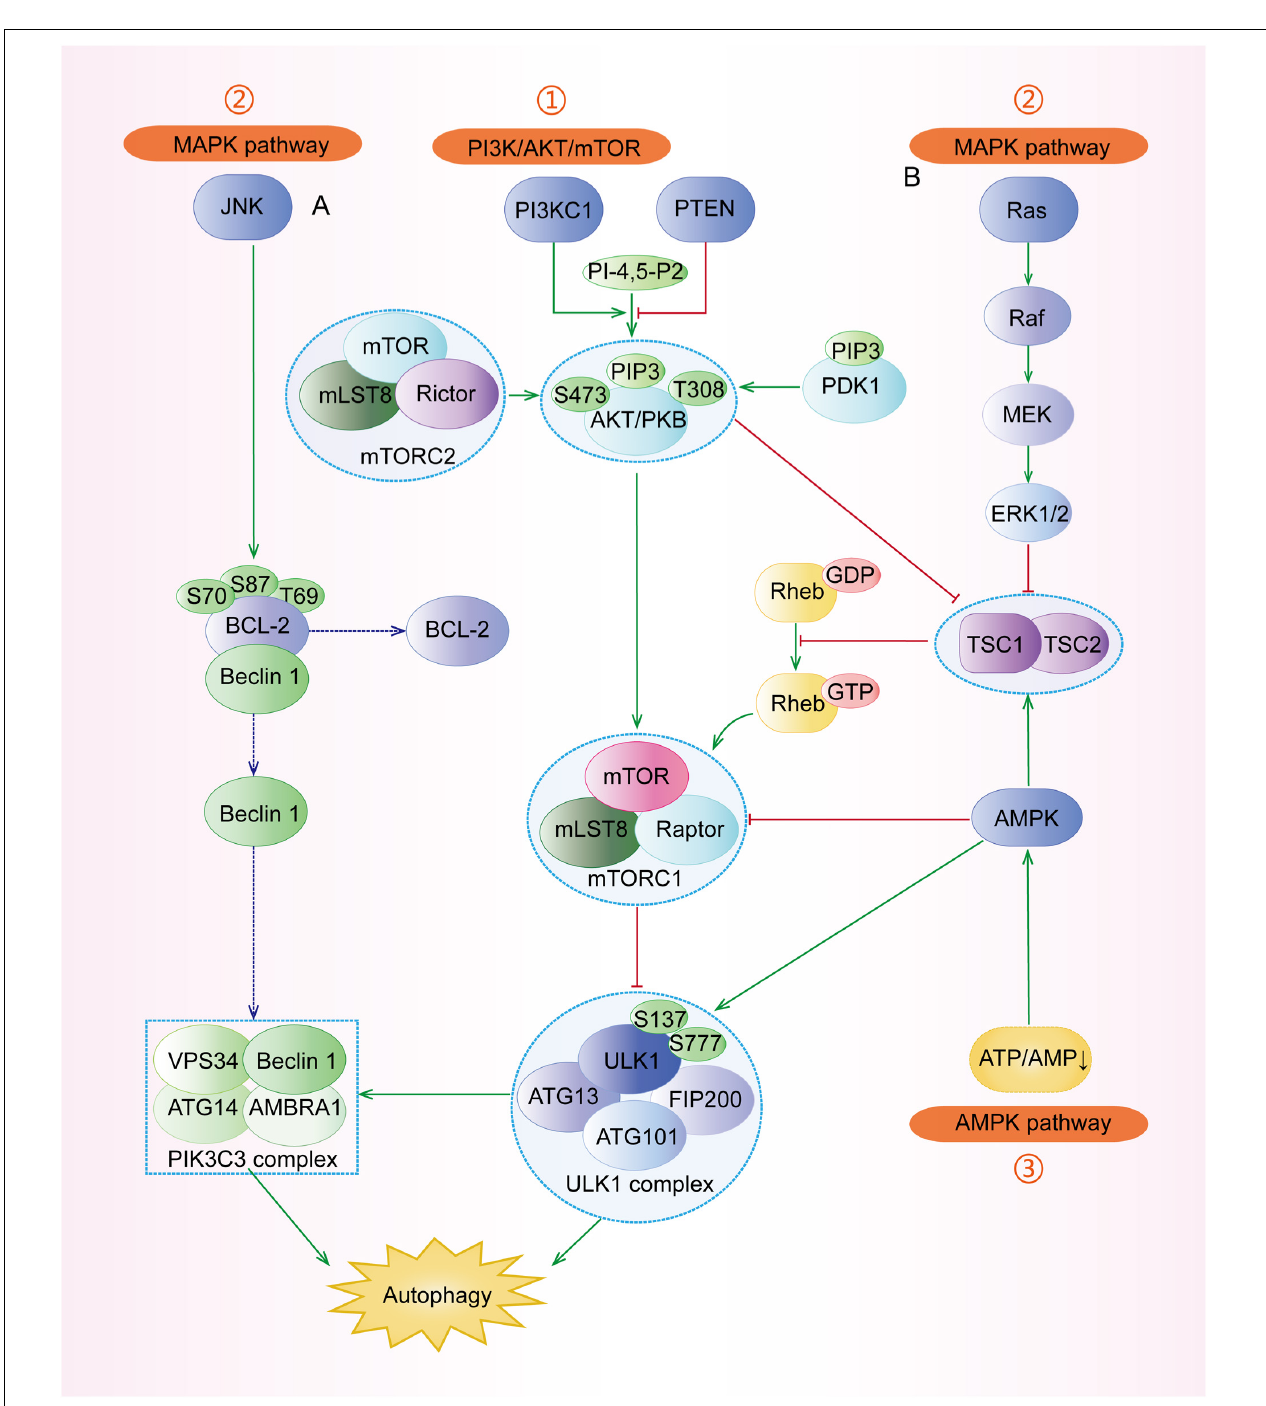
FIGURE 3 | The major signaling pathways involved in the regulation of autophagy. (1) PI3K/AKT pathway: under stresses, the activated PI3KC1 makes PI-4,5-P2 into PIP3 and then activates AKT with the help of PDK1. The activated AKT, directly and indirectly, activates mTORC1 (composed of mTOR, mLST8, and Raptor) to inhibit ULK1 complex and autophagy. Specifically, the indirect pathway includes the TSC1/TSC2 complex and Rheb-GTP. (2) MAPK pathway: the major regulators include the JNK pathway and the ERK pathway. (A) JNK can separate the conjunction of Beclin-1 and BCL-2 by phosphorylating BCL-2 at Thr69, Ser70, and Ser87, and then Beclin-1 participates in the assembly of PIK3C3 complex to induce autophagy. (B) ERK has dual roles in autophagy. The successively activated Ras-Raf-MEK-ERK1/2 can directly induce autophagy. Besides, the activated ERK1/2 can block the TSC1/TSC2 complex and regulate its downstream to inhibit autophagy. (3) AMPK pathway: Under some conditions with the increasing AMP/ATP ratio, the activated AMPK promotes the formation of the TSC1/TSC2 complex to inactivate mTORC1 and regulates its downstream regulators. AMPK can also phosphorylate ULK1 at Ser317, Ser777, S467, S555, S574, and S637 to stimulate